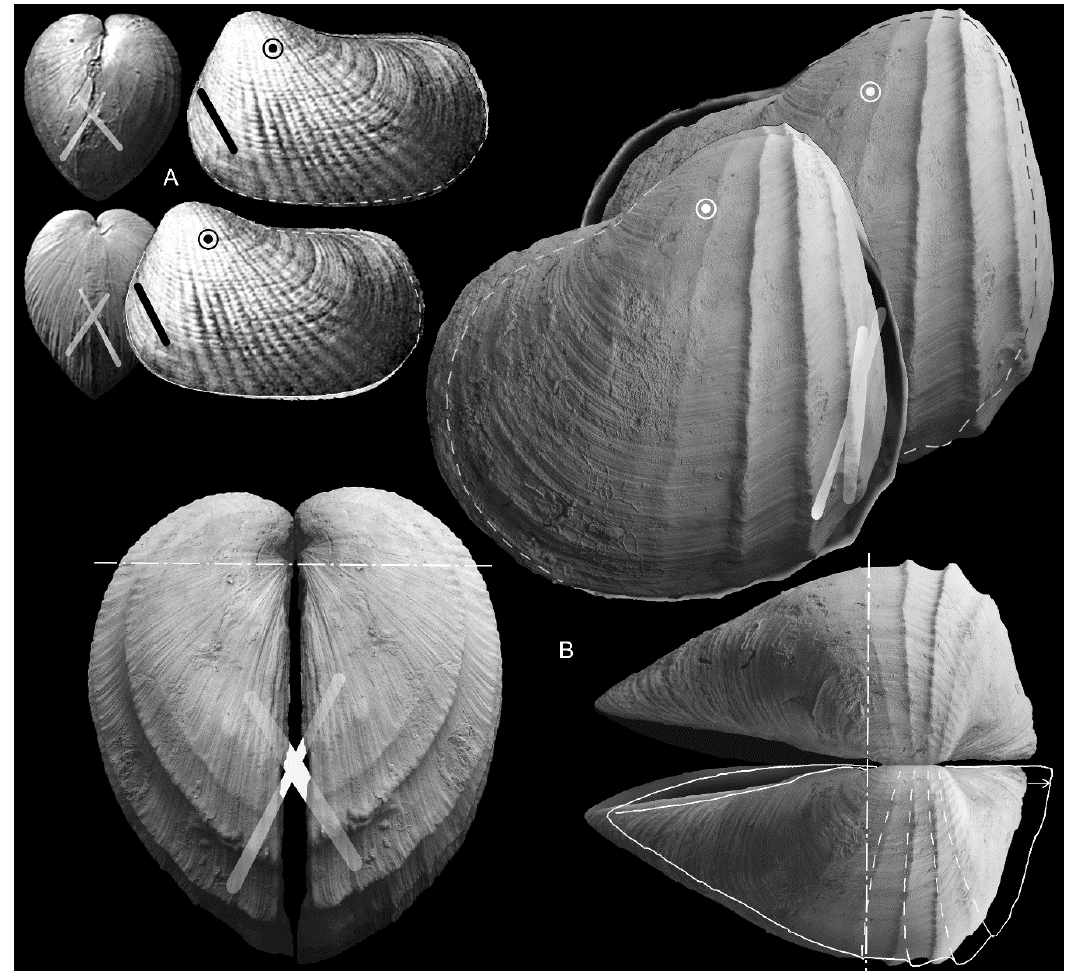
Figure 10. Mechanism of cruciform muscle-aided movement in the sediment, as exemplified by: ( A ), Ph. candida (from Moesch 1874–1875); and ( B ), Pholadomya protei (reconstructed specimen MGUS.Sz.3577, Callovian, Zalas, Polish Jura). The rotation axis and the hypothetical position of the cruciform muscle indicated. Contracted bands drawn thicker. The range of motion may be much smaller in Ph. candida due to smaller spaces between the ribs.